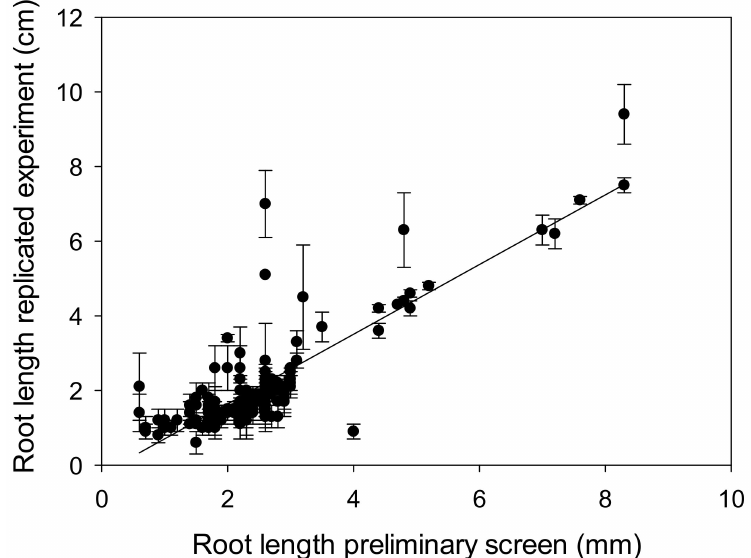
Figure 2. Relationship between total root length of the individual seedlings selected (total root length from the preliminary screen, n = 1 for each accession) that had the longest roots and the total root length of the resulting progeny of the selections showing the average of 10 or more seedlings (in three replications). Error bars indicate the standard error of the mean for the three